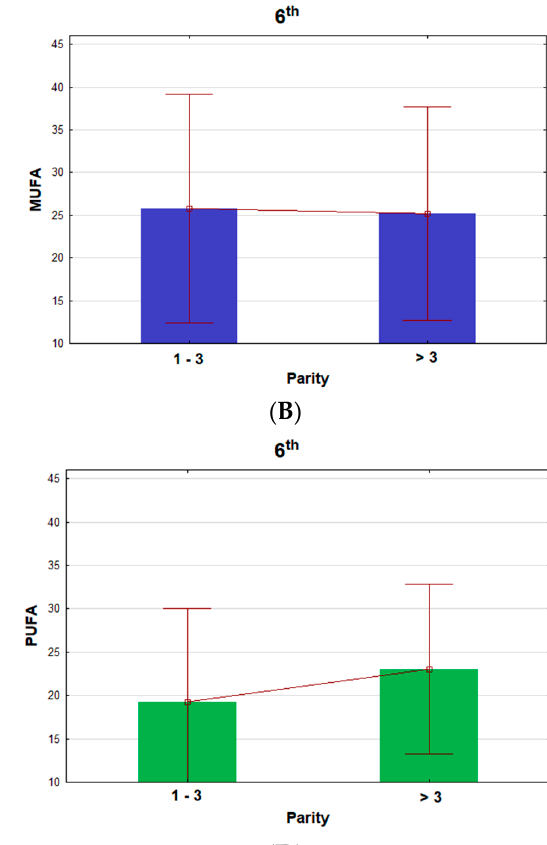
Figure 1. Fatty acids (% of total lipids) according to the parity and stage of lactation (in the fourth month ( A , C ); in the sixth month ( B , D )). MUFAs; C10:1, C12:1, C14:1 cis-9, C16:1 cis-9, C16:1 trans-9, C17:1 cis-9, C18:1 cis-9, C18:1 cis-11, C18:1 cis-12, C18:1 trans-9, C18:1 trans-11, and C20:1 cis-11, PUFA; C18:2 cis-9, trans-11, C18:2 cis-9, cis-12, C18:3 cis-6, cis-9, cis-12, C18:3 cis-9, cis-12, cis-15, C20: 2n − 6, C20: 3n − 6, C20: 4n − 6, C20: 5n − 3, and C22: 5n − 3.